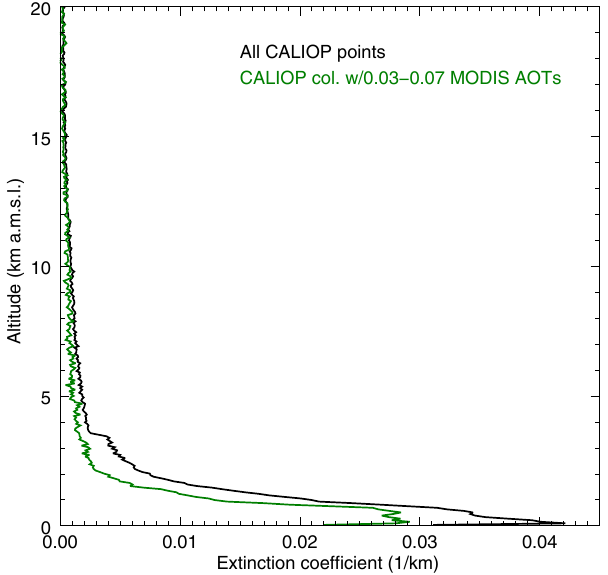
Figure 9. For February 2008 over cloud-free global oceans: the all- RFV aerosol extinction coefficient profiles derived from the inver- sion algorithm. The black curve represents all cloud-free CALIOP profiles over global oceans, while the green curve is from an analy- sis restricted to only those CALIOP points collocated with MODIS AOTs between 0.03 and